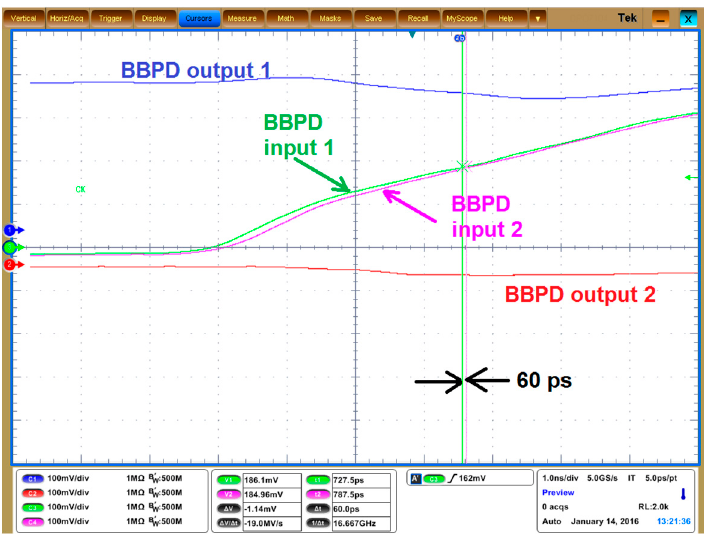
Figure 24. Measurement result of the minimum detectable time difference. When the time difference of the input signals to the BBPD is reduced down to 60 ps, the BBPD can still gives correct output. According to (7), (8) and (10), the frequency resolution limit imposed by the BBPD is calculated as